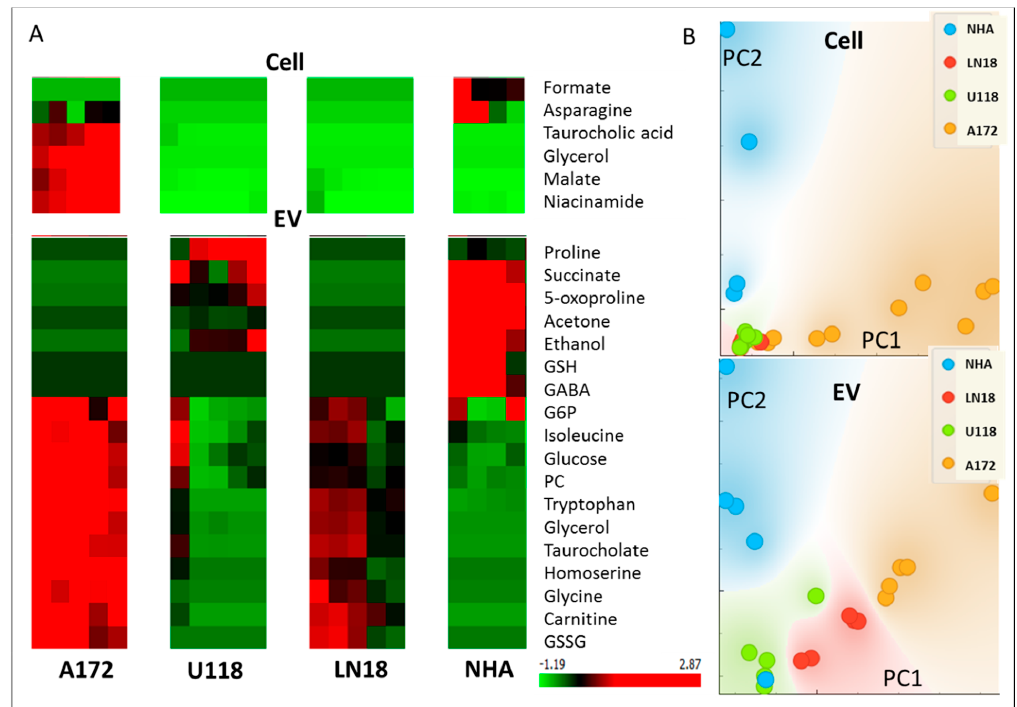
Figure 5. ( A ) ANOVA selection of the most different metabolites between cell four cell types in cells and EV extracts. Shown are metabolites with ANOVA > 5.G6P—Glucose 6-phosphate;